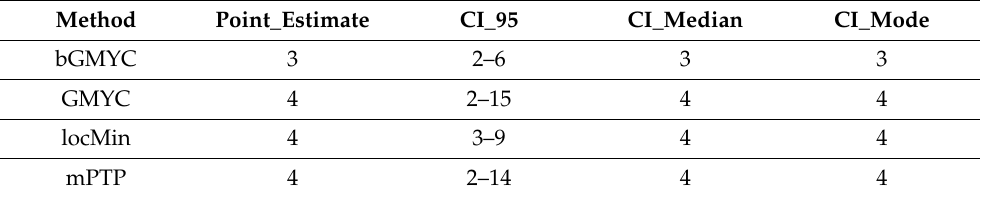
Table 1. Numbers of candidate species estimated by four methods of species discovery analysis based on mitochondrial sequences from individuals of the Phrynops geoffroanus species complex. Point estimate = average, CI_95 = 95% confidence interval range, median, and